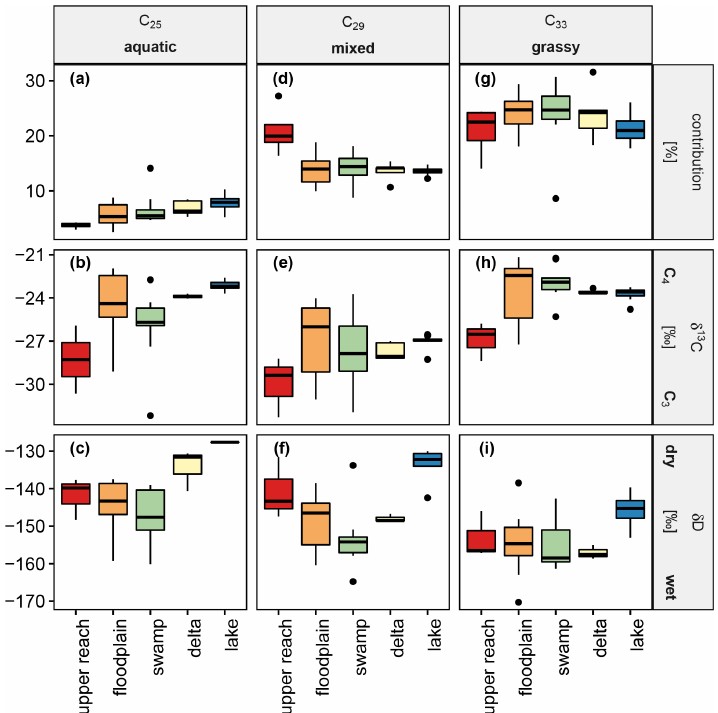
Figure 8. Box-and-whisker plots show the relative concentration in percent (a , d , g) , carbon isotope signatures with respect to VPDB in per mil (b , e , h) and hydrogen isotope signatures with respect to VSMOW in per mil (c , f , i) of the n -alkanes C 25 , C 29 , and C 33 as representatives of the groups of n -alkanes classified as aquatic, mixed, and